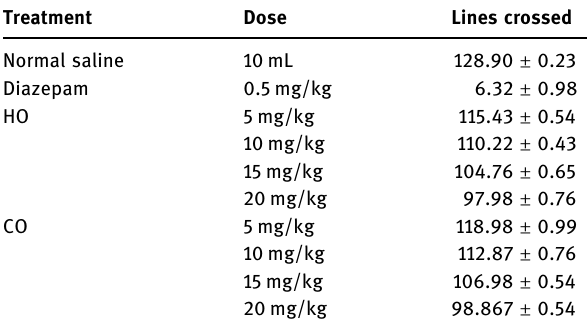
Table 8: Sedative activity of oil extracts from HO and CO fractions of